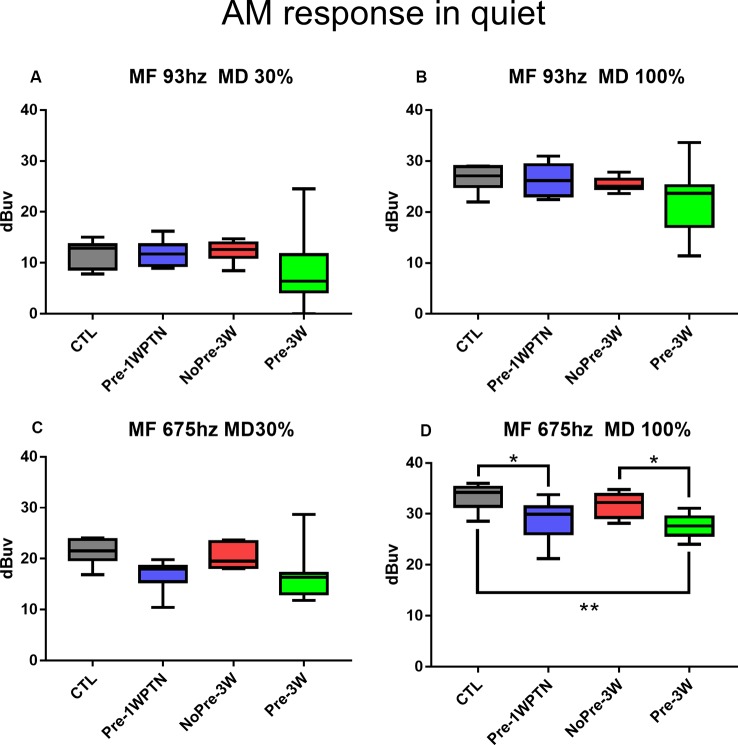
Comparison of AM CAP amplitudes in the quiet condition. (A–D) AM CAP obtained at different modulation frequencies and depths indicated in the panel titles. CTL, control group; Pre-1WPTN, 1week post-toughening noise group; 3W, 3 weeks post-high-level noise; NoPre, group without pre-exposed; Pre, group with pre-exposed. The number of asterisks shows the significant level o (*p < 0.05, **p < 0.01) of the post hoc tests (Tukey method) after one-way ANOVA.